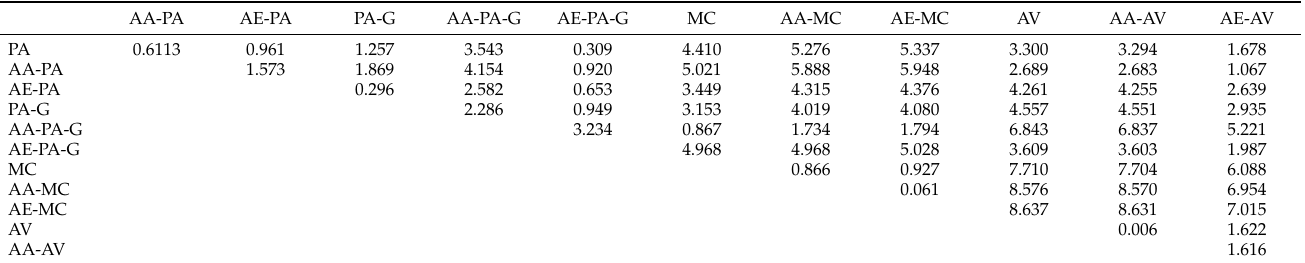
Table 1. The differences between means obtained from Tukey’s test; the value of HSD was 0.188.